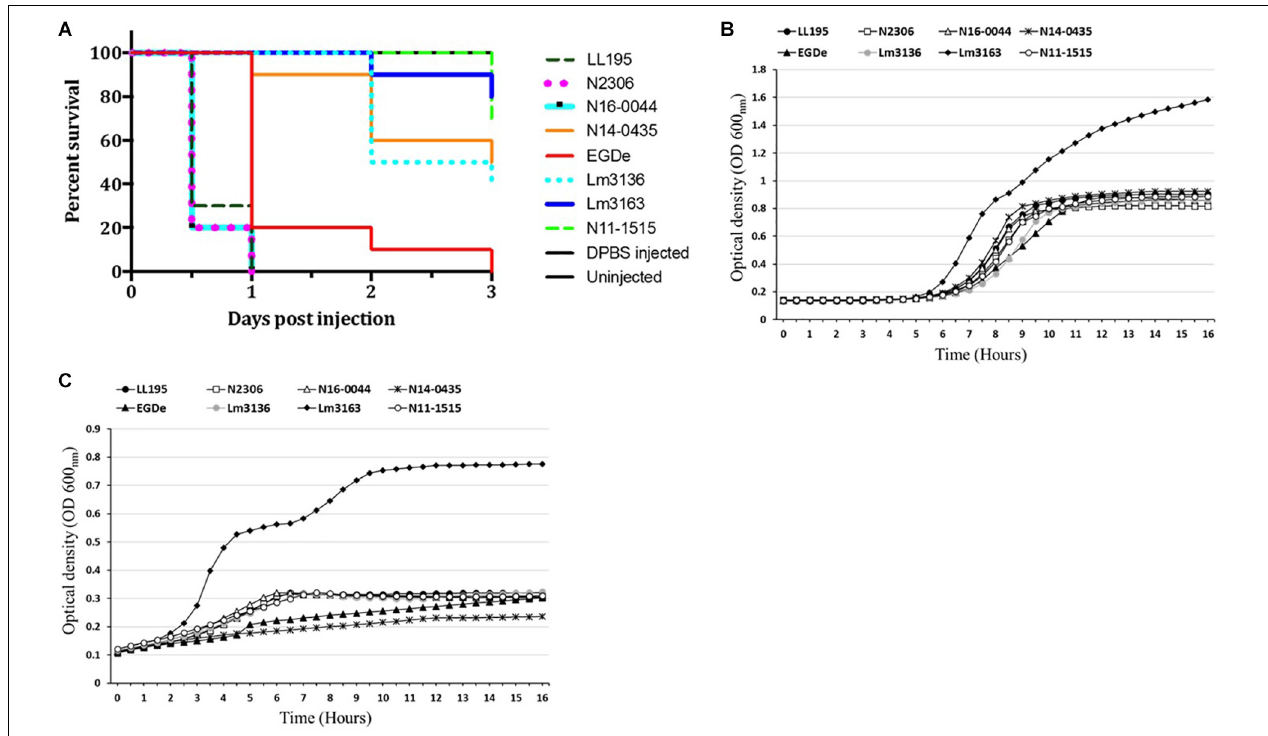
FIGURE 5 | Strains vary in virulence and growth in BHI and MEM media. (A) Virulence was assessed using a zebrafish infection model. Zebrafish embryos ( n = 10 per strain) infected (500 CFU) with different Listeria monocytogenes strains were monitored over 3 days. Zebra fish embryos more rapidly succumbed to serotype 4b compared to serotype 1/2a strains. Kinetic growth assays in (B) BHI and (C) MEM based on OD 600 measurement showing varied growth of the examined L. monocytogenes strains with Lm3163 displaying the greatest growth capacity and biphasic growth in both media compared to the other strains.